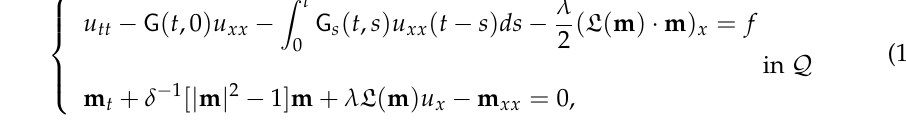
Figure 2. Spring system